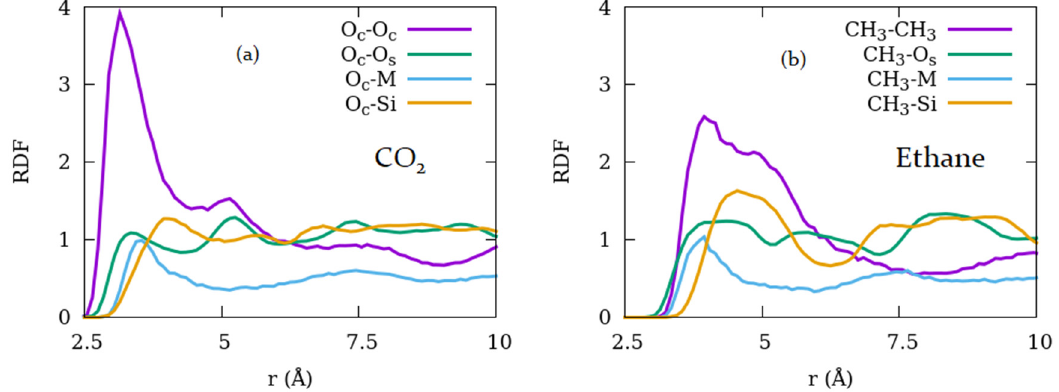
Figure 7. Radial distribution functions of the fluid-fluid and fluid-substrate pairs for ( a ) CO 2 and ( b ) Ethane adsorbed in S2Z2 at 100 atm.